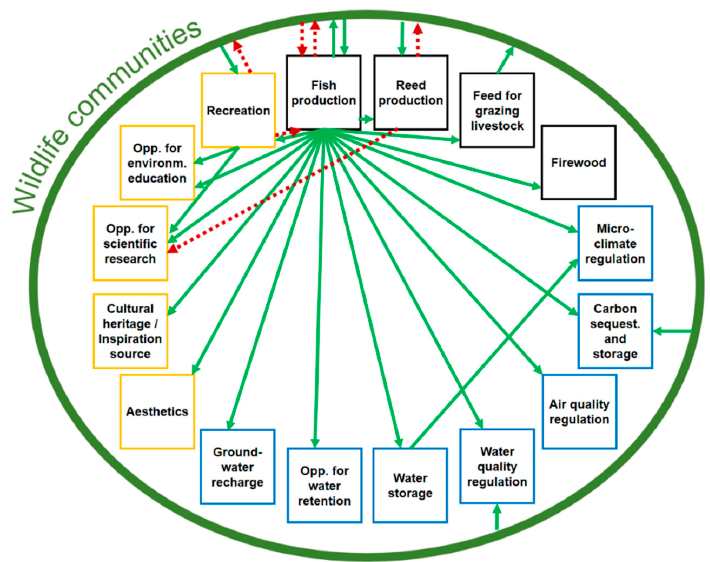
Figure 3. Impacts and interactions between the listed ESs revealed by key-informants (green circle around all ESs—fishpond systems’ wildlife communities; black squares—provisional ES; blue square—regulating and maintaining ES; orange square—cultural ES; green arrows—positive impacts; red arrows with broken lines—negative impacts).